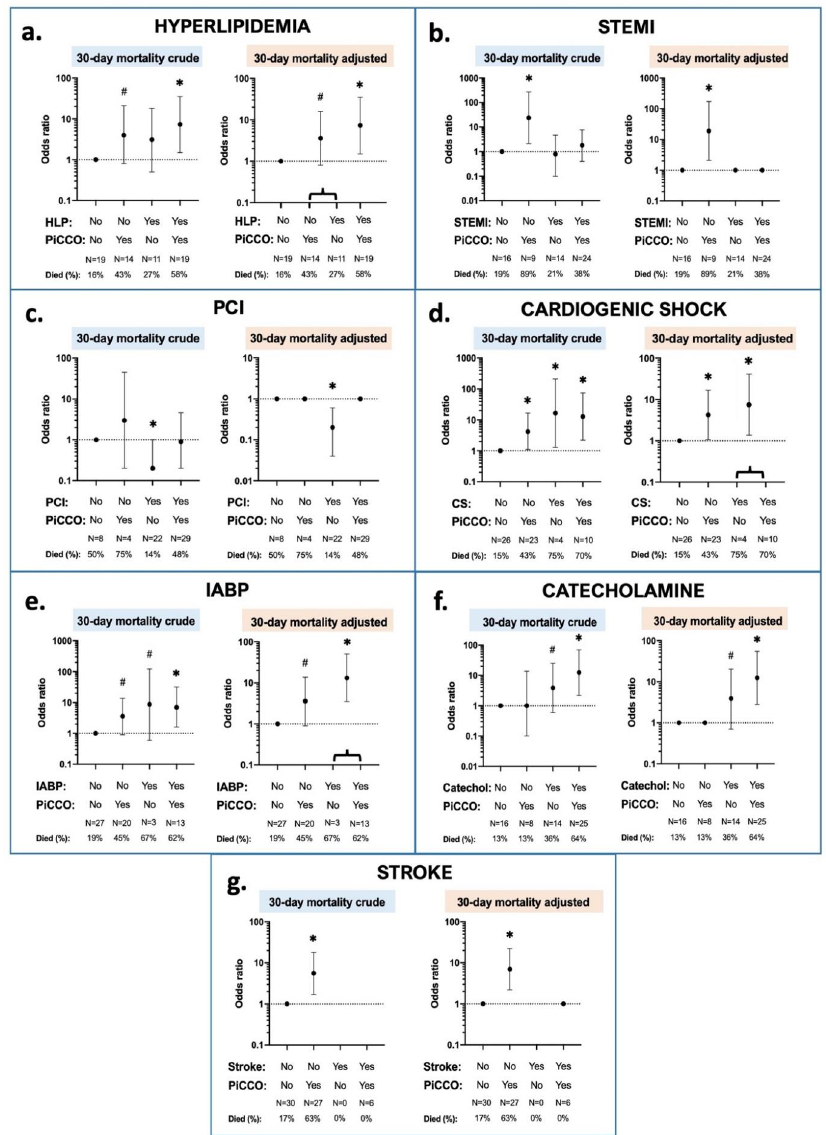
Figure 5. Interaction effects between PiCCO ™ -application, 30 day mortality, and patient condition characteristics. Patient conditions are depicted in the different subfigures; ( a ) hyperlipidemia; ( b ) STEMI at admission; ( c ): PCI treatment; ( d ): cardiogenic shock at admission; ( e ): IABP insertion; ( f ): catecholamine administration; ( g ): stroke in the prior history. Crude and adjusted logistic regressions were performed. In the crude models, all the interaction term dummy variables were included as separate variables. In the adjusted models, non-significant dummies were combined. ∗ : p < 0.05; #: p < 0.2; catechol: catecholamine; CS: cardiogenic shock; HLP: hyperlipidemia; IABP: intra-aortic balloon pump; N: number of patients; PCI: percutaneous coronary intervention; PiCCO: pulse index contour cardiac output; and STEMI: ST-elevation myocardial